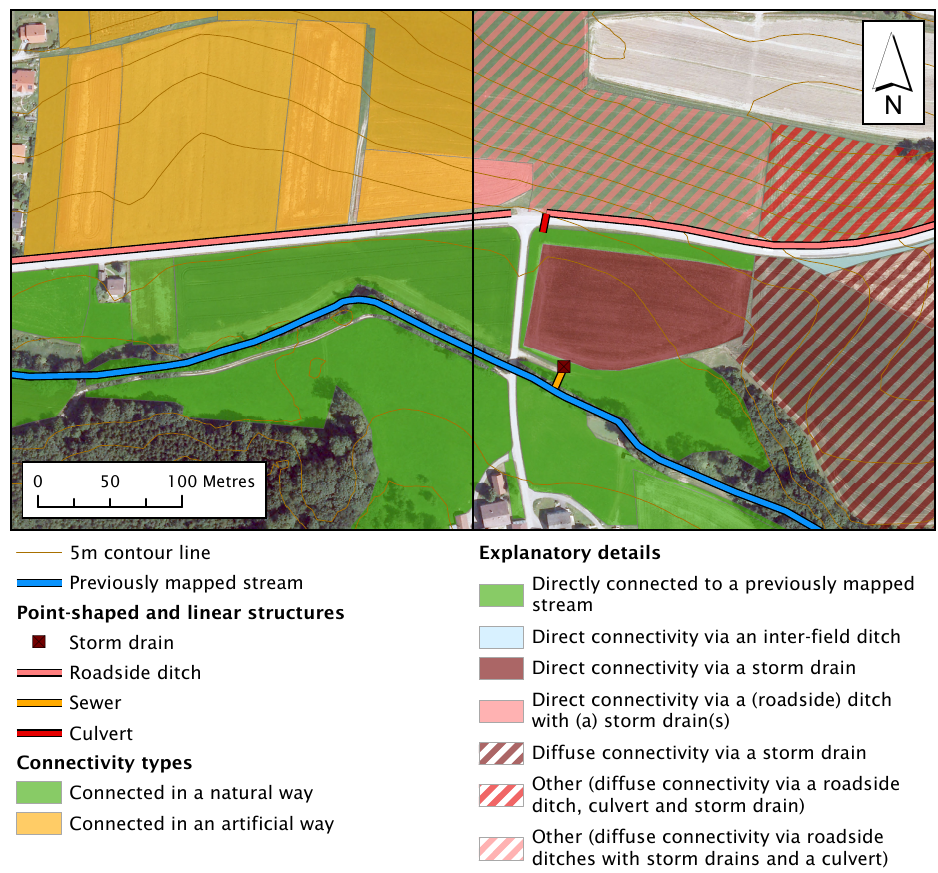
Figure 5. Exemplified visualisation of some of the results of the field mapping campaign with connectivity types shown on the left and explanatory details on the right side of the figure. The part above connectivity types on the left side of the legend is common to both sides. Please note that the top- and rightmost, bright looking field behind the north arrow does not belong to the mapped cluster. Table 4. Causes of influence on emissions and transport pathways expressed as percentage of all influenced fields as well as all mapped